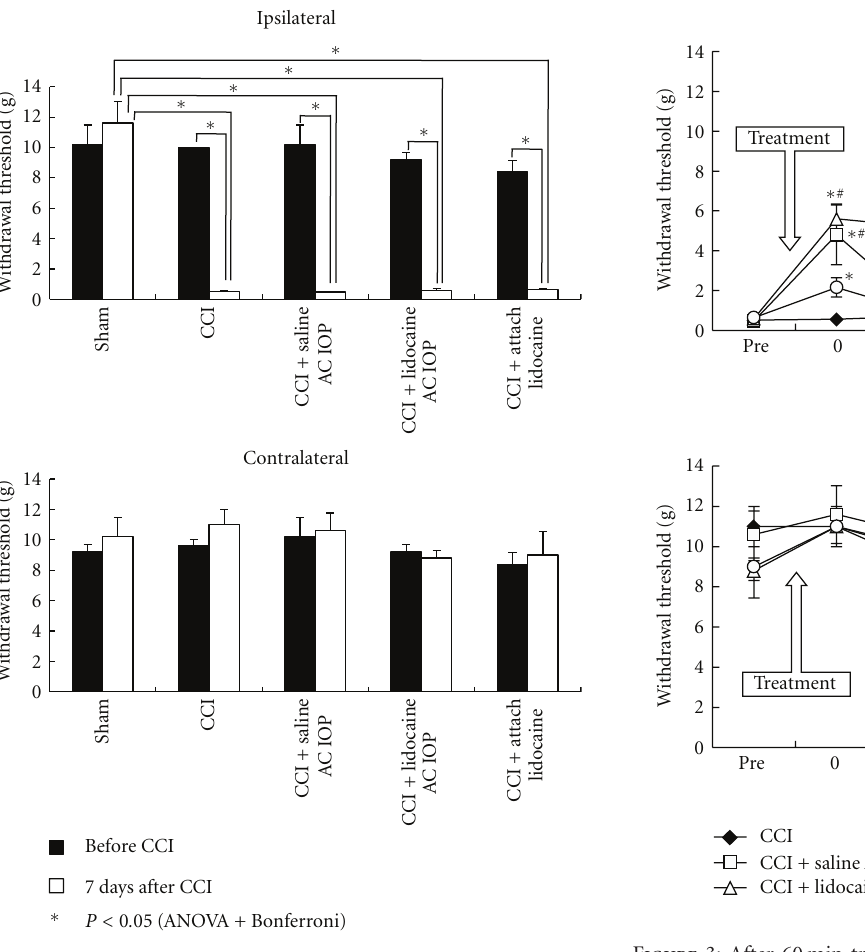
Figure 2: Change in mechanical withdrawal thresholds 7 days after chronic constriction injury (CCI) (mean ± SEM). The values of 7 days after CCI decreased significantly on the ipsilateral side compared with the preoperative values. In addition, a significant di ff erence was observed between the sham group and other groups. ∗ P < 0 . 05, n = 5. the facial skin for 60 min (CCI + attach lidocaine group: n = 5).